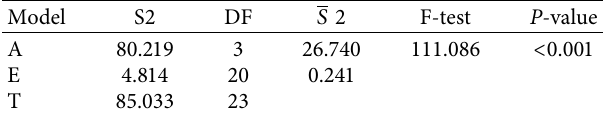
Table 6: ANOVA results.